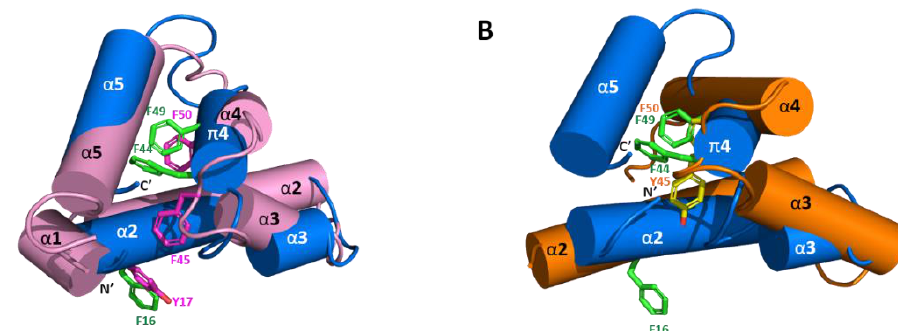
Figure 4. Superposition of Sco-CHH-L with Pej-MIH and Pej-SGP-I-Gly. Structure of Sco-CHH-L (blue) is superposed with ( A ) Pej-MIH (pink) and with ( B ) Pej-SGP-I-Gly (orange). Note that Sco-CHH-L is well aligned with Pej-MIH with the N- and C -terminus being brought near together, while the two termini of Pej-MIH are kept away in Pej-SGP-I-Gly. Side chains of the conserved aromatic residues in Sco-CHH-L (Phe 16 , Phe 44 , and Phe 49 in green), MIH (Tyr 17 , Phe 45 , and Phe 50 in magenta), and Pej-SGP-I-Gly (Tyr 45 and Phe 50 in yellow) are shown. Note the aromatic ring of Phe 16 /Tyr 17 pointing away from the core structure.